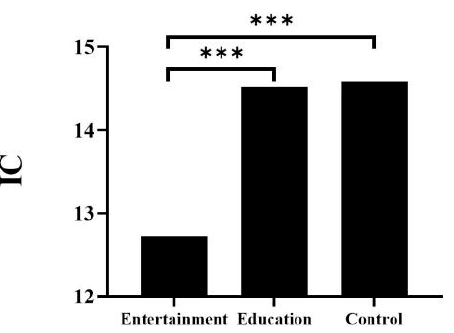
Figure 1. Comparison of IC in different groups. *** p < 0.001; IC: inhibitory control.